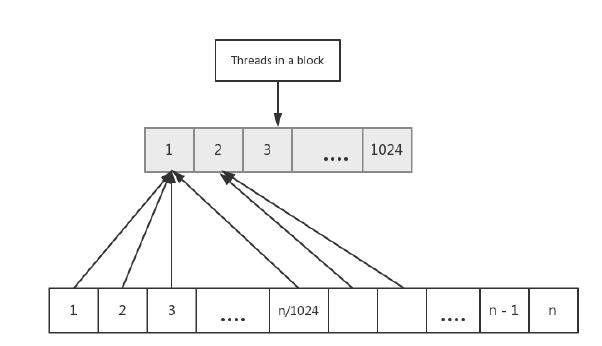
Fig. 3. GPU threads mapping in a block, variable n represents the size of the array variable, which is need to copy onto the GPU device. (Block dimension is 1024).